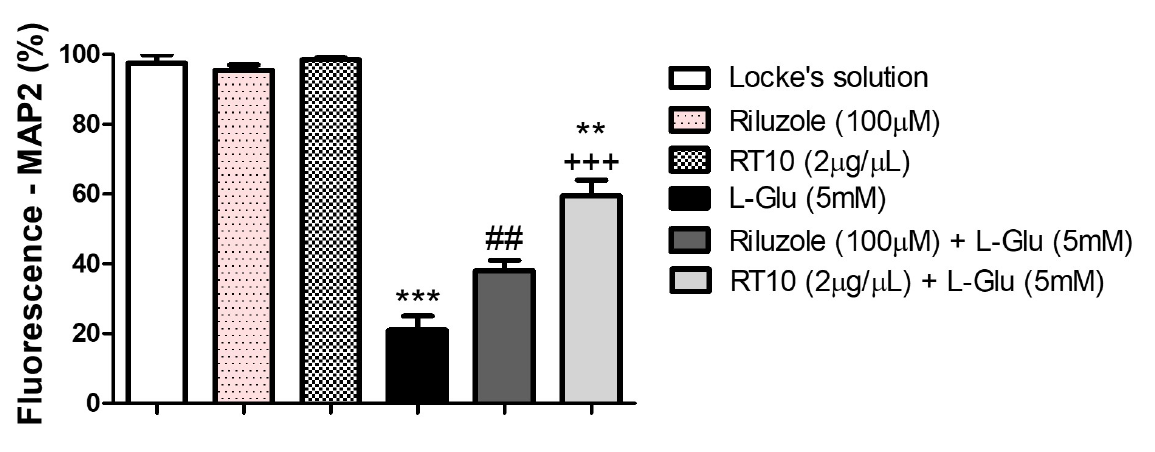
Figure 5. Normalized levels of FI in cells labeled with MAP2. Data are expressed as mean ± S.E.M. Cultures were treated with either riluzole (100 μM) or RT10 (2 μg/μL) for 3 hours prior to exposure to L- Glu (5mM) for 12 hours. (***p< 0.001 vs Locke’s solution group; ##p<0.01 vs. L- Glu; +++p<0.001 vs. L- Glu and **p<0.01 vs. riluzole). One-way ANOVA followed by Newman-Keuls test.